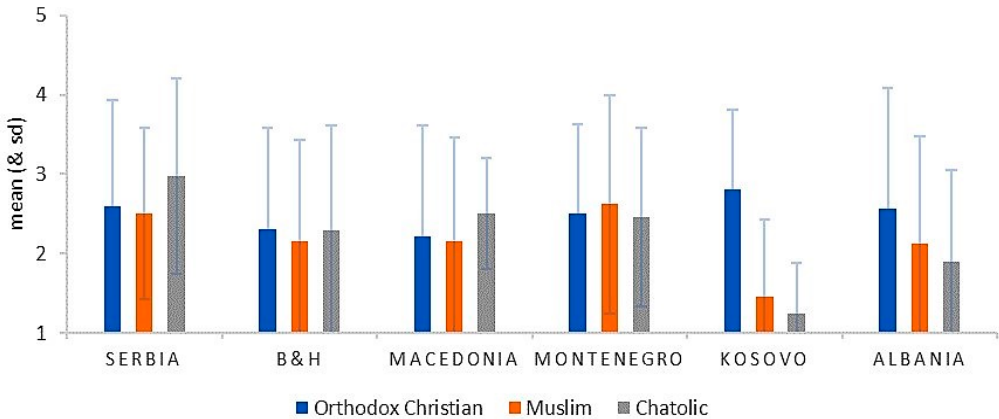
Figure 17. Using connections to get things done by confession and country. (The error bars represent standard deviation).